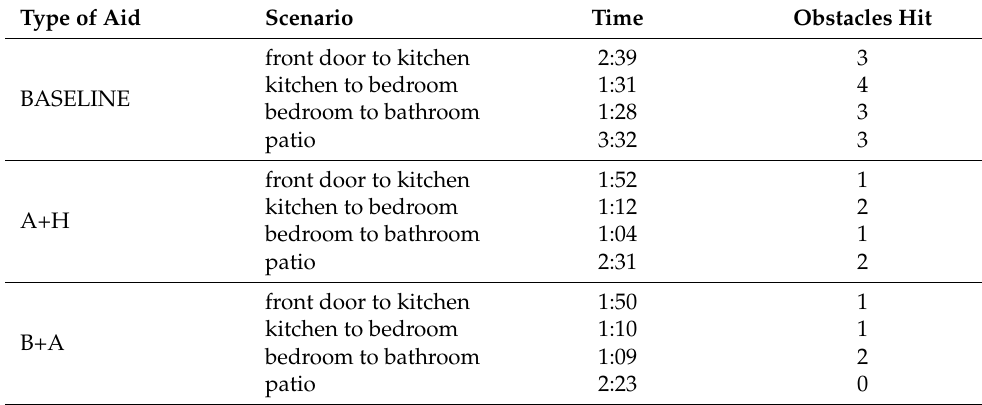
Figure 7. A complex navigation task in an indoor environment. The disabled user needs to navigate from the bedroom to the bathroom, avoid obstacles such as the bed and the chair, and must find and open the appropriate doors. Table 3. Experimental results for the complex navigation